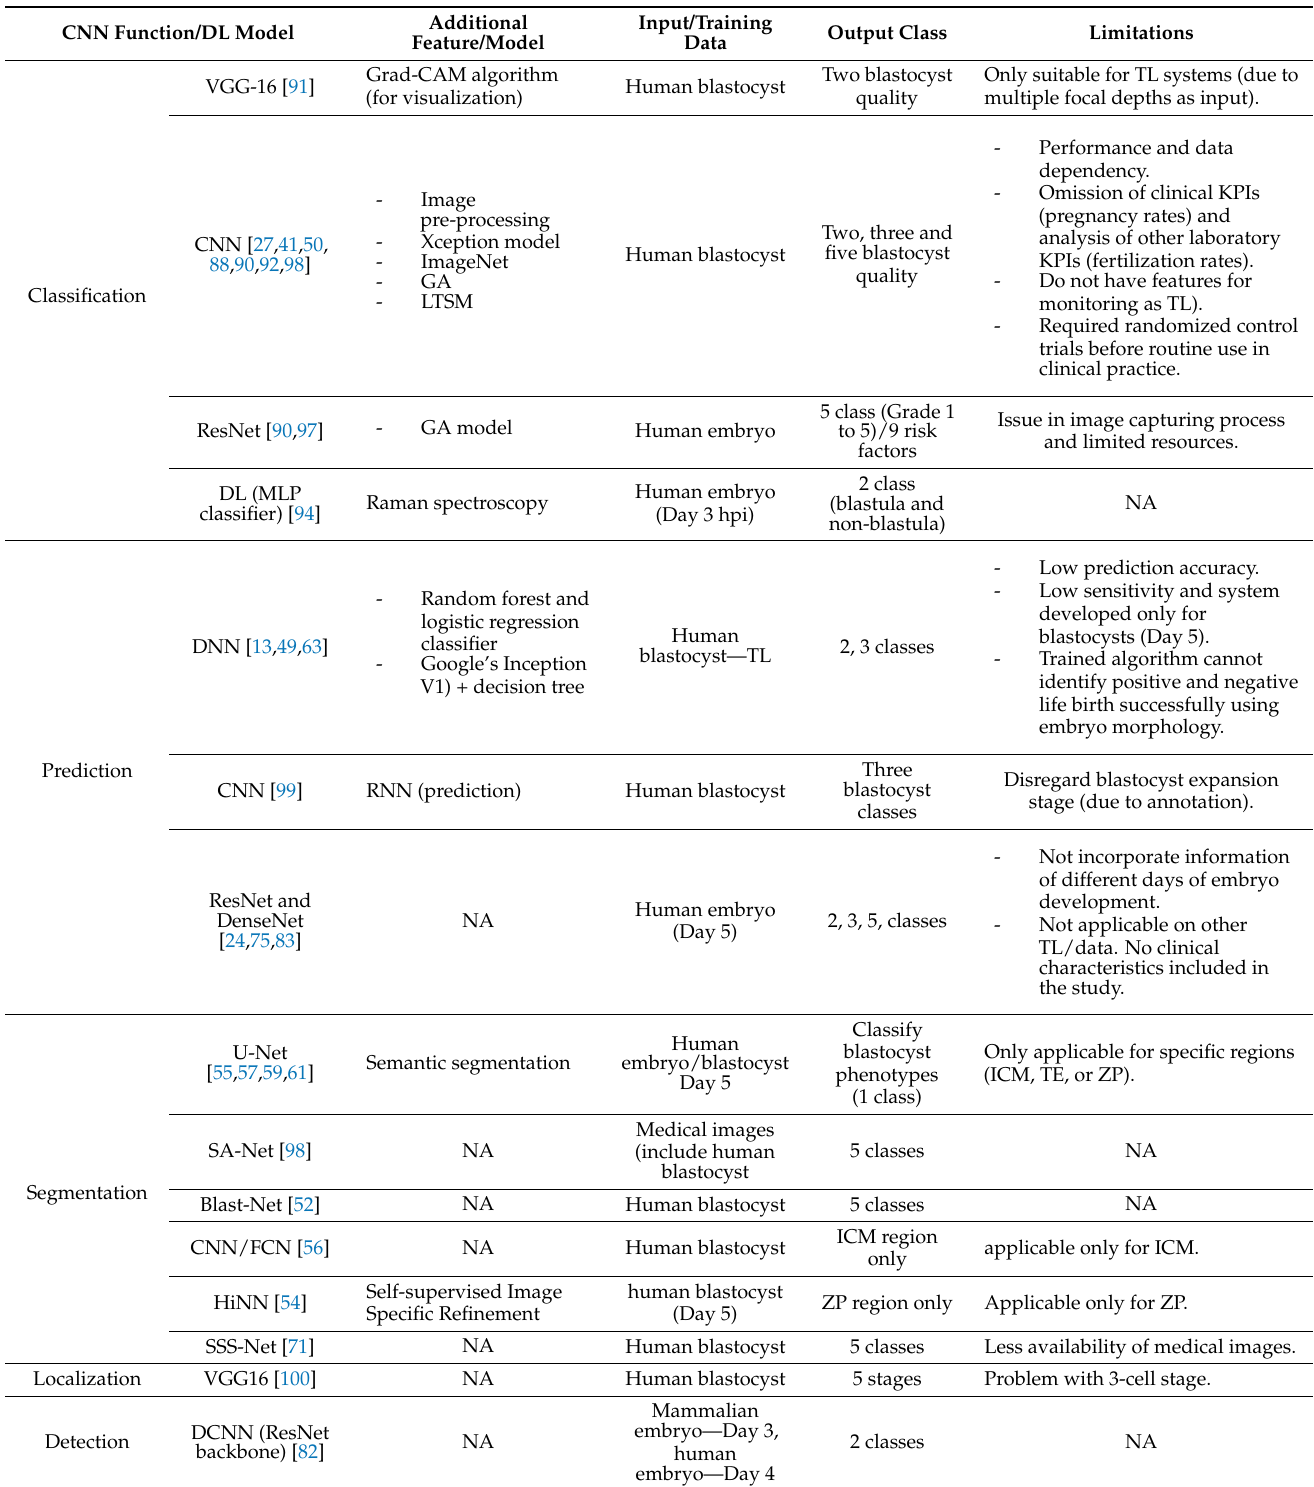
Table 3. Comparisons studies associated with the blastocyst using deep learning